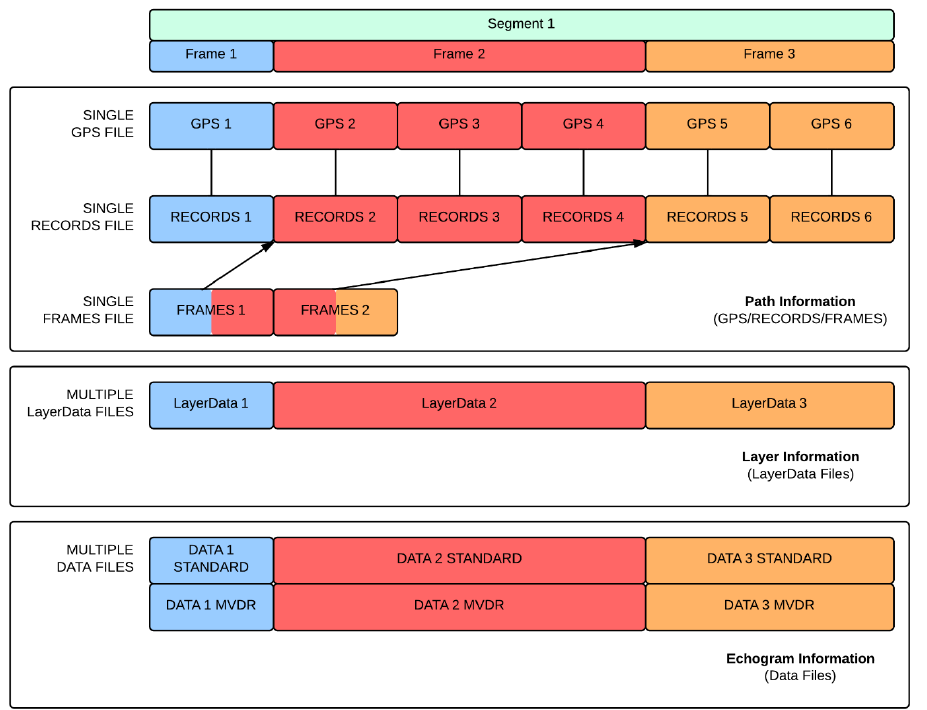
Figure 2. An example set of CReSIS data for a single data collection segment. Three files (one GPS, one RECORDS, and one FRAMES) store the flight path data, three files (one LayerData per frame) store the digitized layers, and a minimum of three DATA files (one per frame per processing type) store radar echograms.